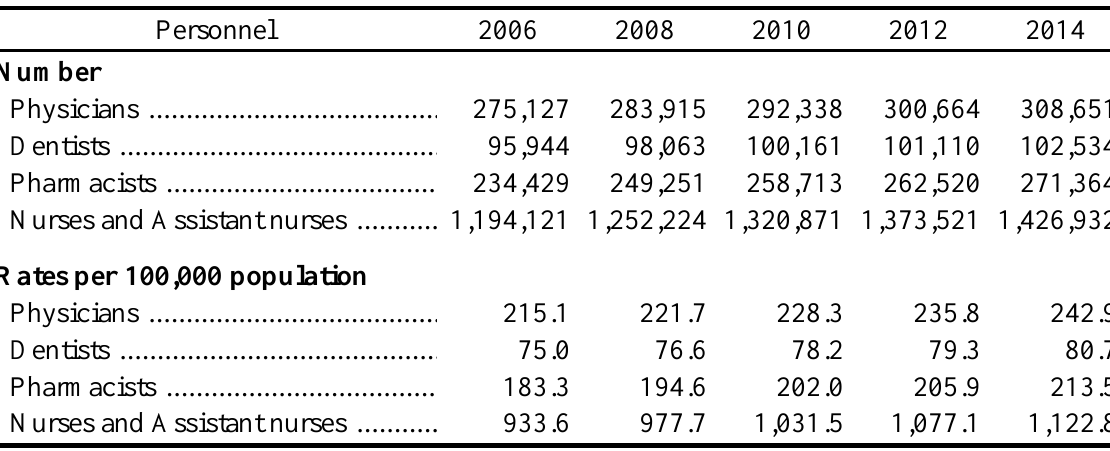
Table 15.2 Medical Personnel at